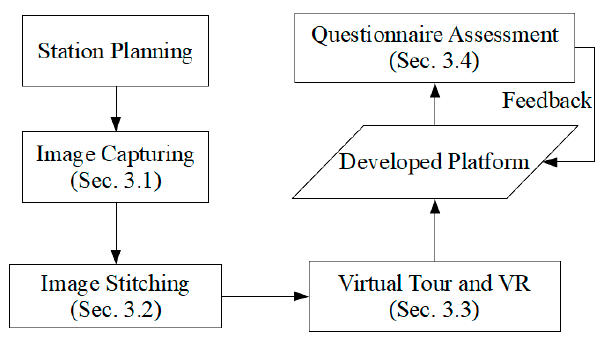
Figure 1. The conceptual procedure used in this study.